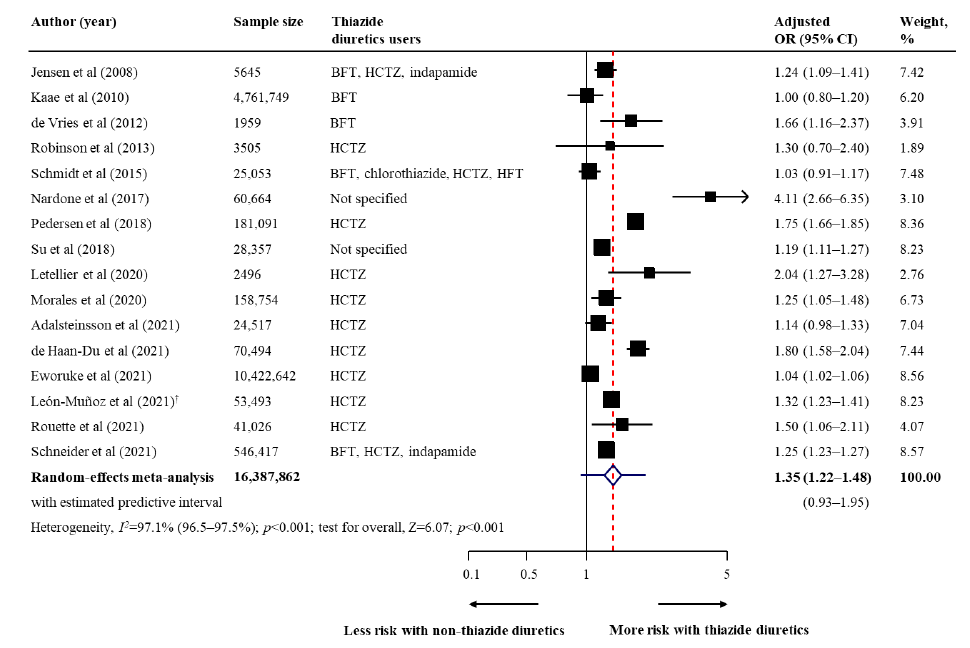
Figure 2. Effect of the use of thiazide diuretics and the risk of basal cell carcinoma. Abbreviations: BFT, bendroflumethiazide; CI, confidence interval; HCTZ, hydrochlorothiazide; HFT, hydroflume- thiazide; OR, odds ratio [30–33,37,38,40,47,48,50,53,56–58].